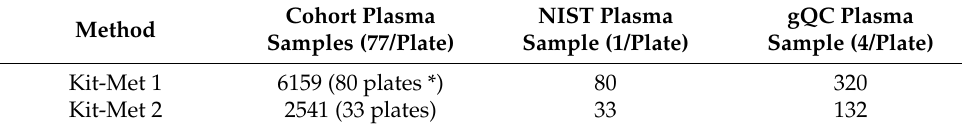
Table 2. Summary of samples.